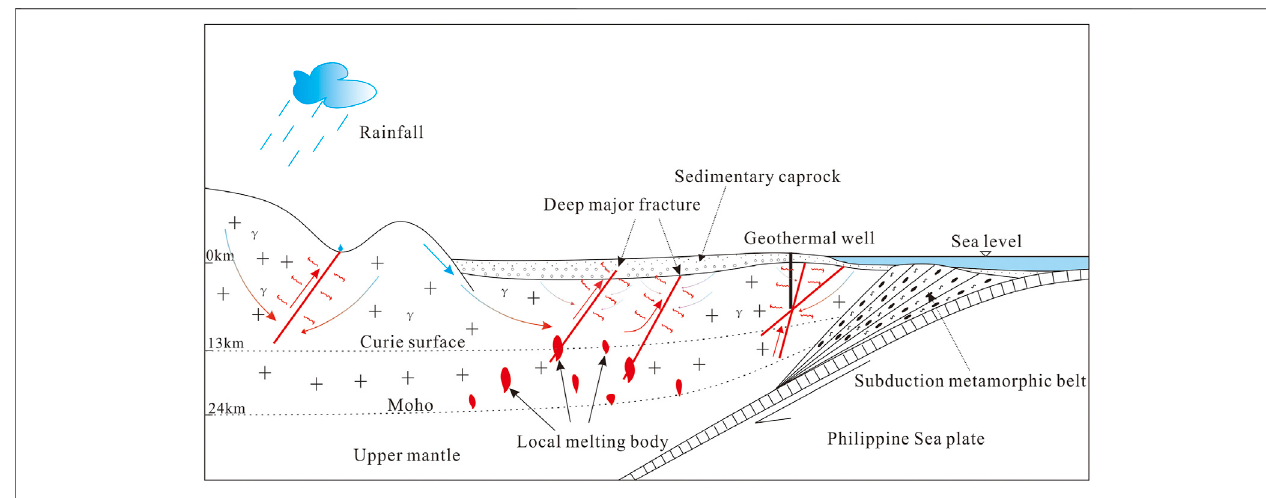
FIGURE 9 | Diagram showing the genetic model of geothermal resources in igneous rock areas in the southeast coastal areas of China.